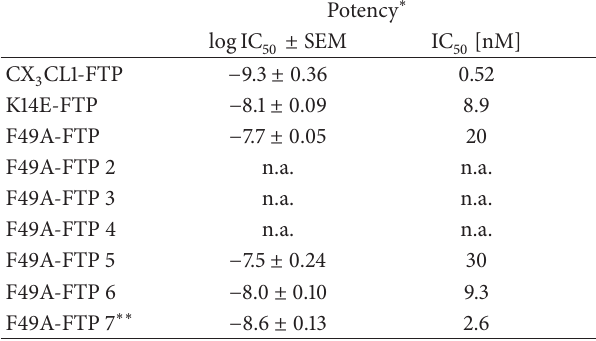
Table 3: Antiviral activity of the